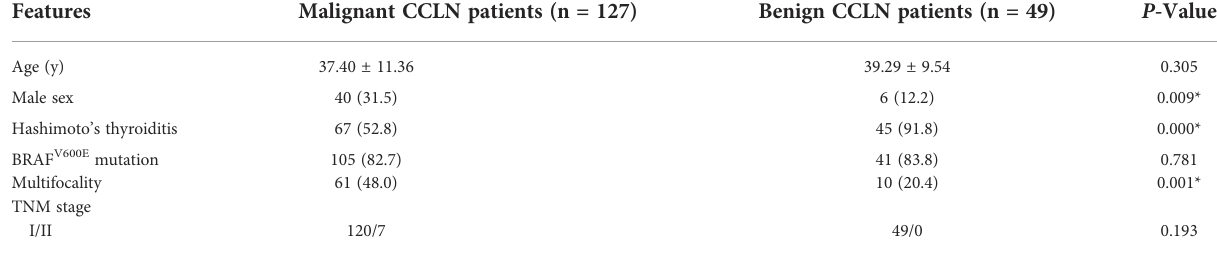
TABLE 1 Clinical features of the patients with malignant and benign CCLNs.